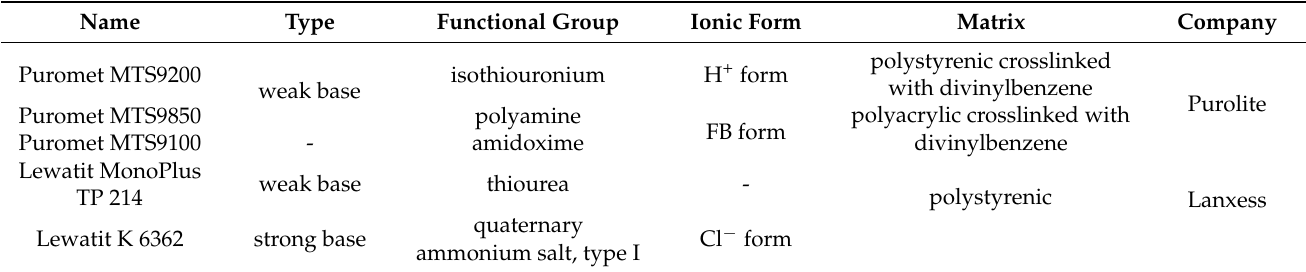
Table 1. Resins used in the